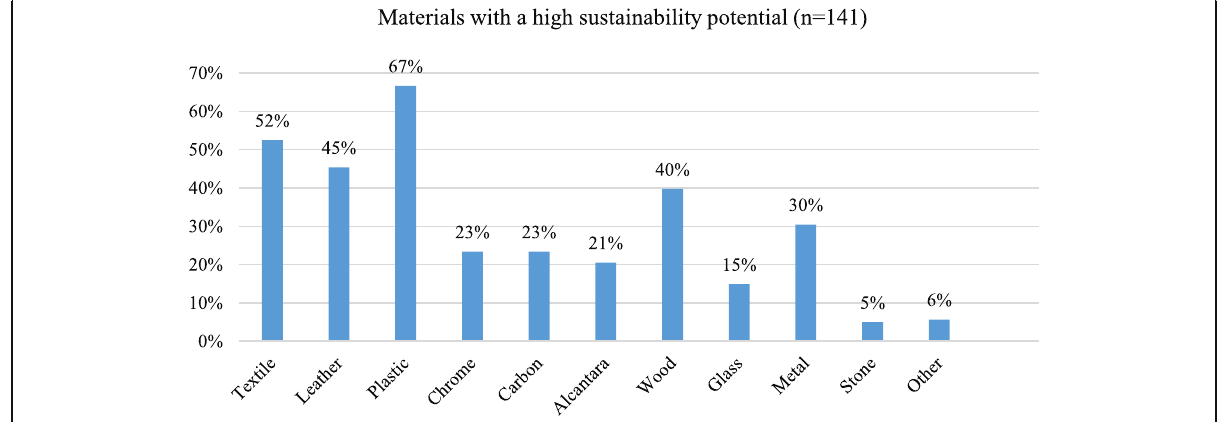
Fig. 6 Materials with a high sustainability potential. Source: Own